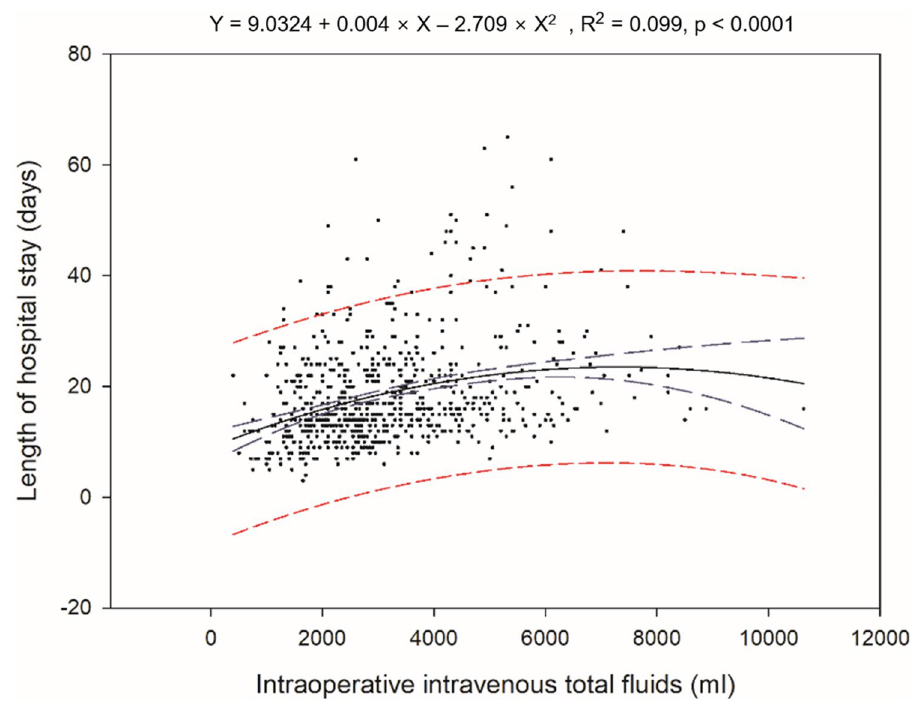
Figure 2. Regression curves on the analysis of the association between intraoperative intravenous total fluids and length of hospital stay.